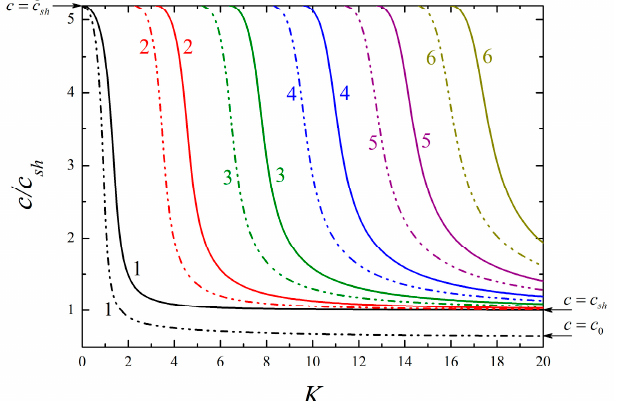
Figure 2. Dispersion curves of the lowest six modes for SH-type surface waves in a piezoelectric film/elastic substrate structure. Dashed–dotted lines indicate the case of the nanostructure with f c = f e = 0.5 nm and f κ = f ρ = 1 nm, and solid lines indicate the case of the corresponding classical structure with f c = f e = f κ = f ρ = 0 nm.